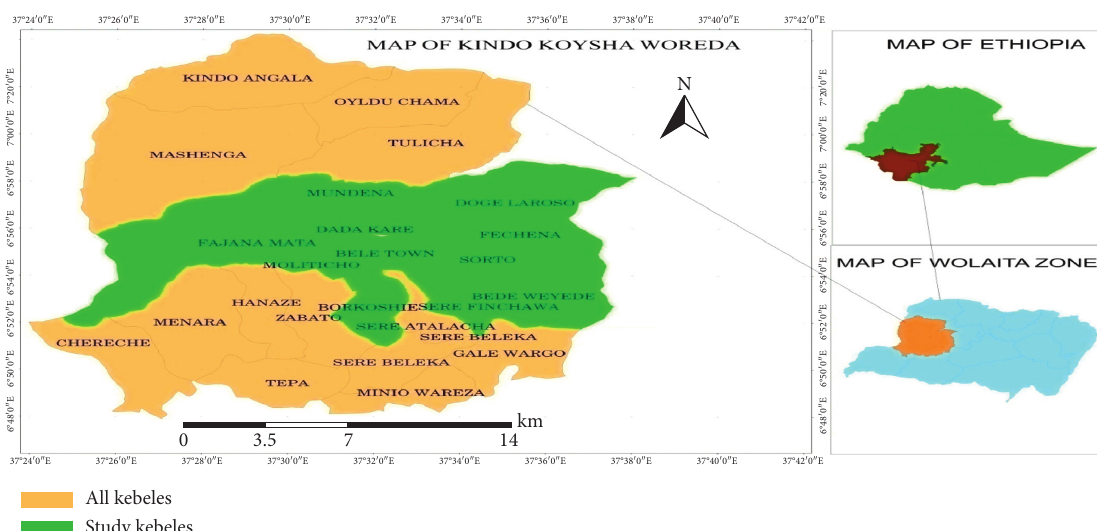
Figure 2: Study area map (source: Finance and Economic Development of Kindo Koysha District